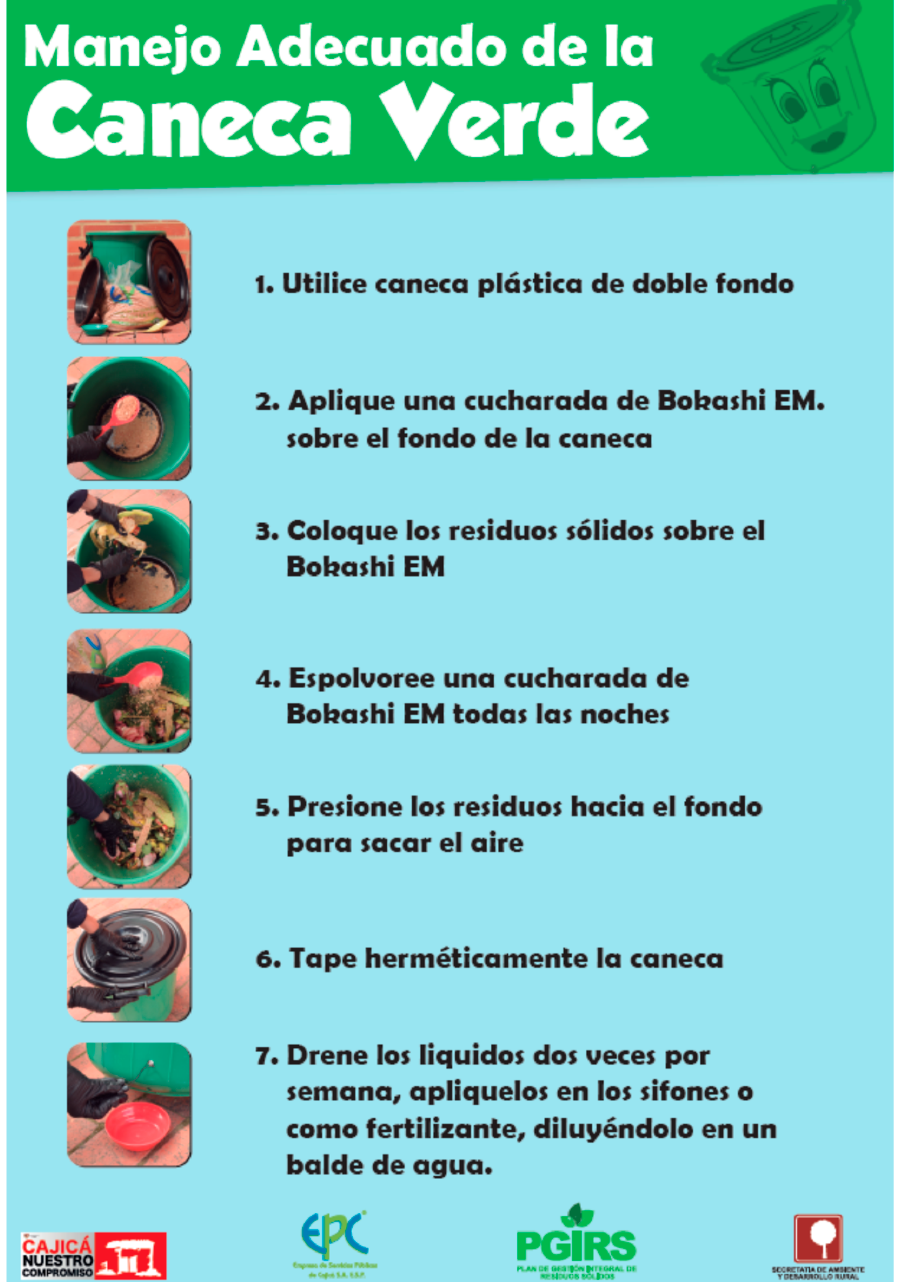
Figure 2. A brochure prepared by the municipality of Cajicá which explains the step-by-step procedure of the composting project to its residents (Poster courtesy of: Cajic á